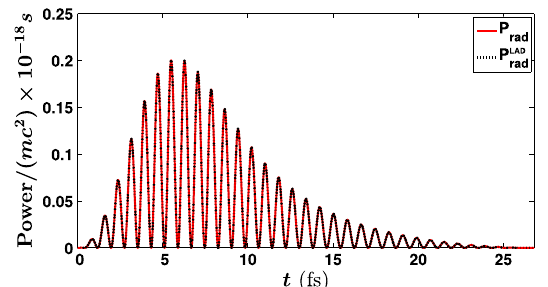
FIG. 5. Longitudinal velocity u z =c plotted vs time t for a sinusoidal-envelope linearly polarized laser pulse with parame- ters given in Fig. 4.